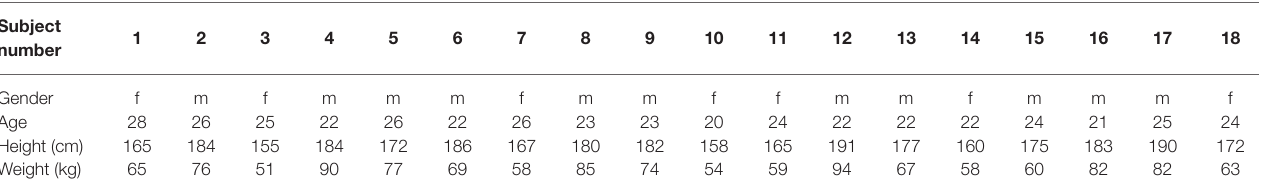
TABLE 1 | Characteristics of participants with subject numbers (m = male, f =